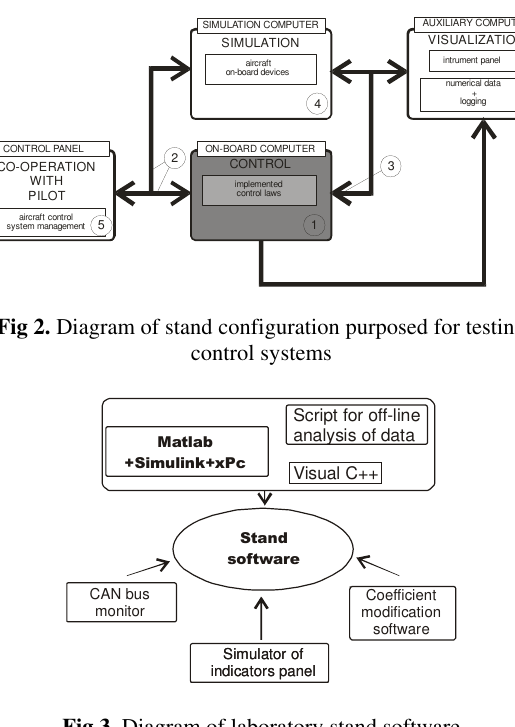
Fig 4. Examples of visualization of laboratory